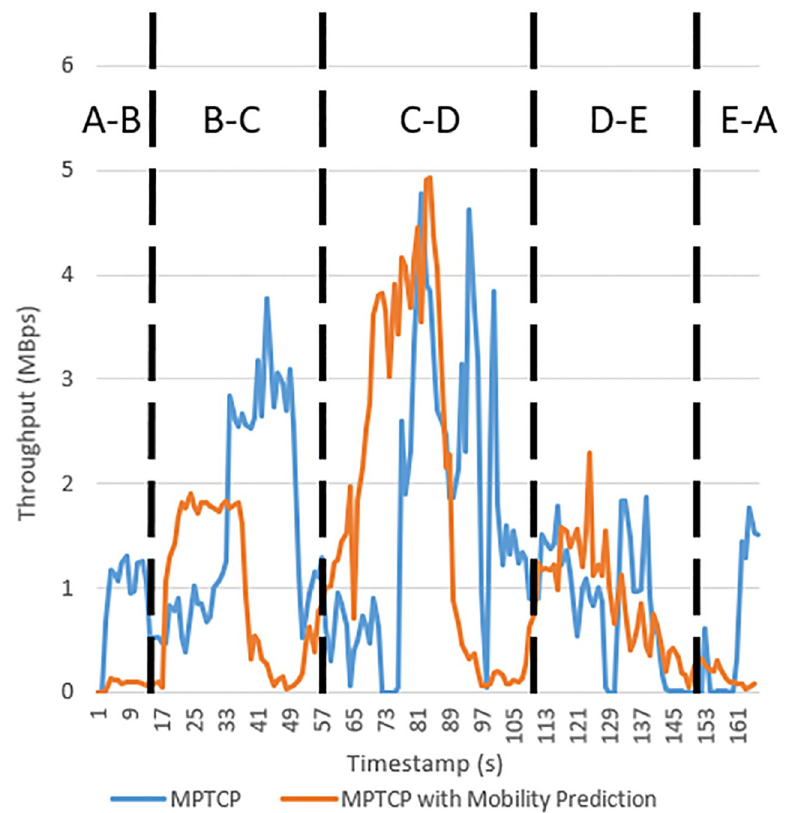
Fig 26. The network throughput of MPTCP and MPTCP with mobility prediction.